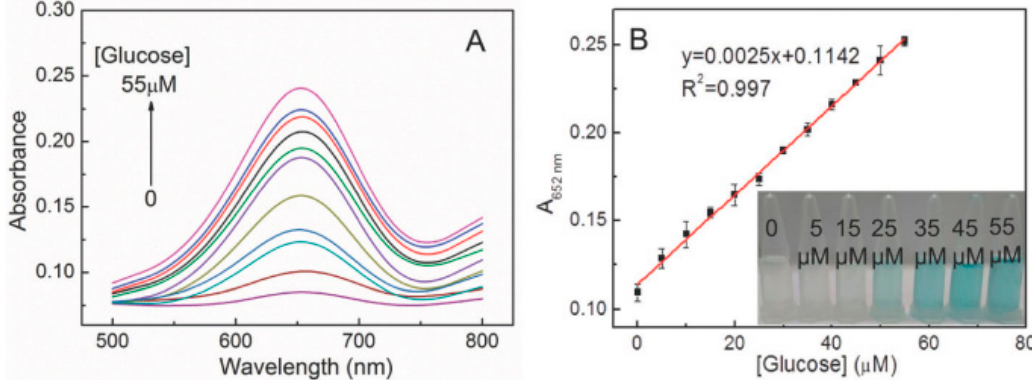
Figure 17. ( A ) Absorption spectra of the Au-Pt NCs-GOx-TMB system in the presence of different glucose concentrations (0, 5, 10, 15, 20, 25, 30, 35, 40, 45, 50, and 55 μ M). ( B ) Linear calibration curve of the absorbance at 652 nm against glucose concentration. The inset shows the corresponding photographs for different concentrations of glucose (Copyright Ref [188], Royal Society of Chemistry).